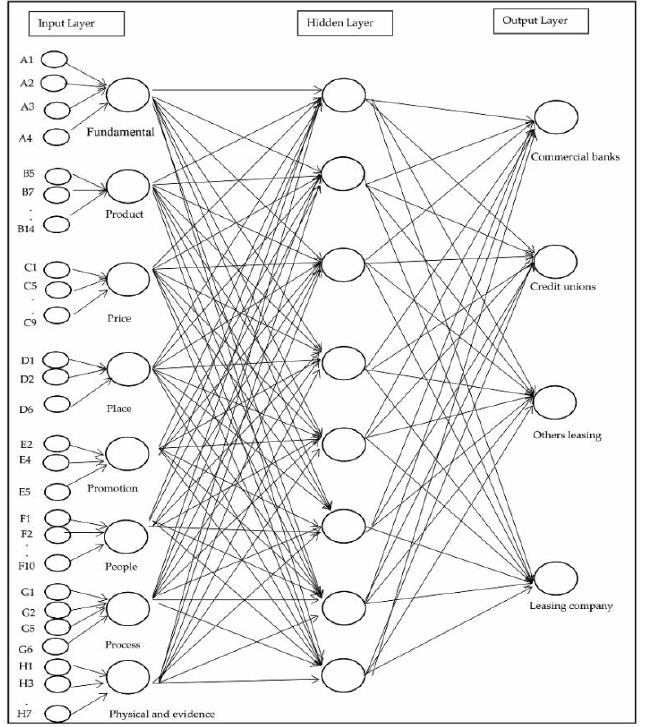
Figure A4. Structure of the NN by using cutting 50% technique model used for predicting.